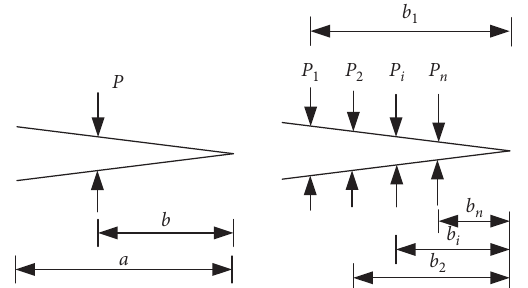
Figure 2: Equalizing fibers effect as a series of concentration force P on the crack